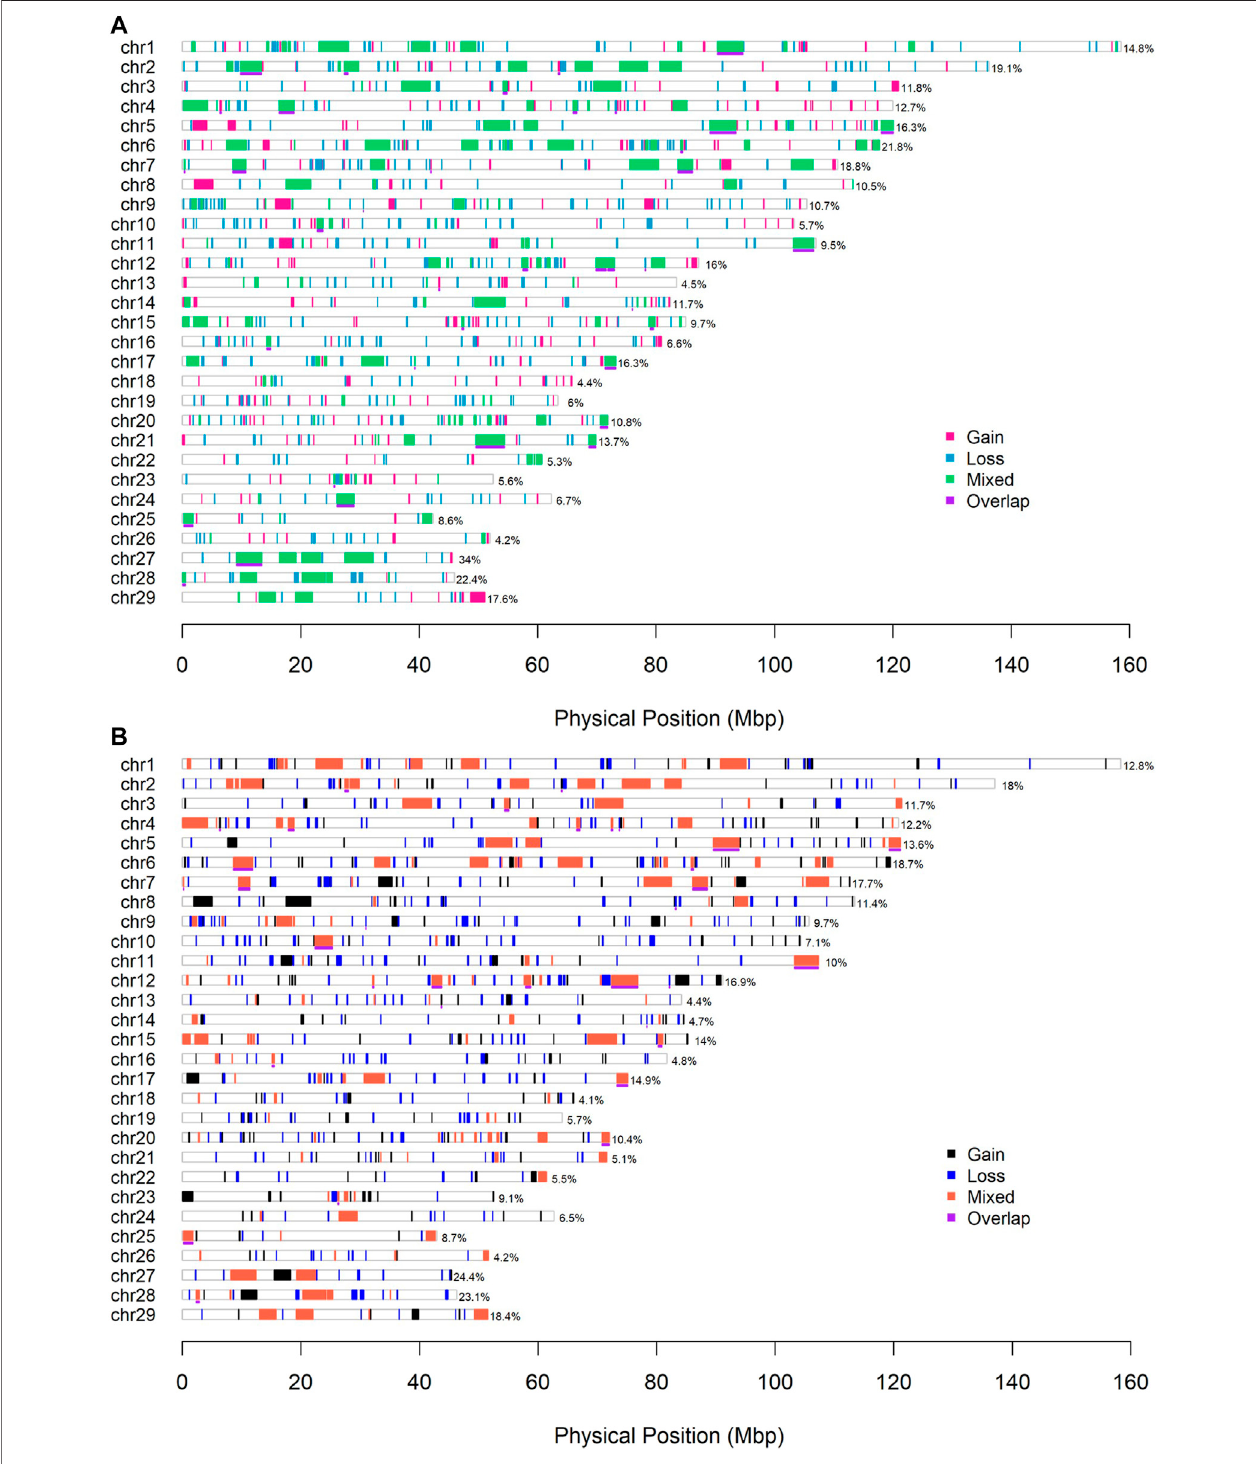
FIGURE4| (CNVRs)distributionmap. (A) TheCNVRmapwiththeARSversion. (B) TheCNVRmapwiththeUMDversion.Theunderlineswithpurplecolorindicate the consensus CNVRs between the two detection methods. The percentage number represent the coverage of CNVRs on each chromosome.